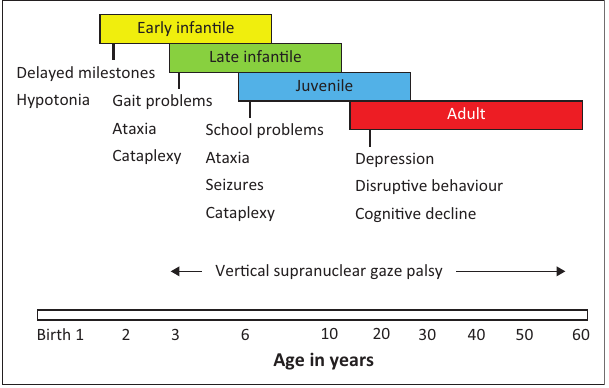
TABLE 1: Overview of the ocular motor examination. Type of examination Question Eye position in primary gaze Vertical or horizontal misalignment. Fixation on a target; square wave jerks; nystagmus Ocular motility Range of motility in eight positions. Gaze evoked nystagmus Saccades Horizontal and vertical saccades. Latency, speed and accuracy Pursuit Smooth or saccadic interruptions VOR Unilateral or bilateral vestibular deficit VOR, vestibulo-ocular